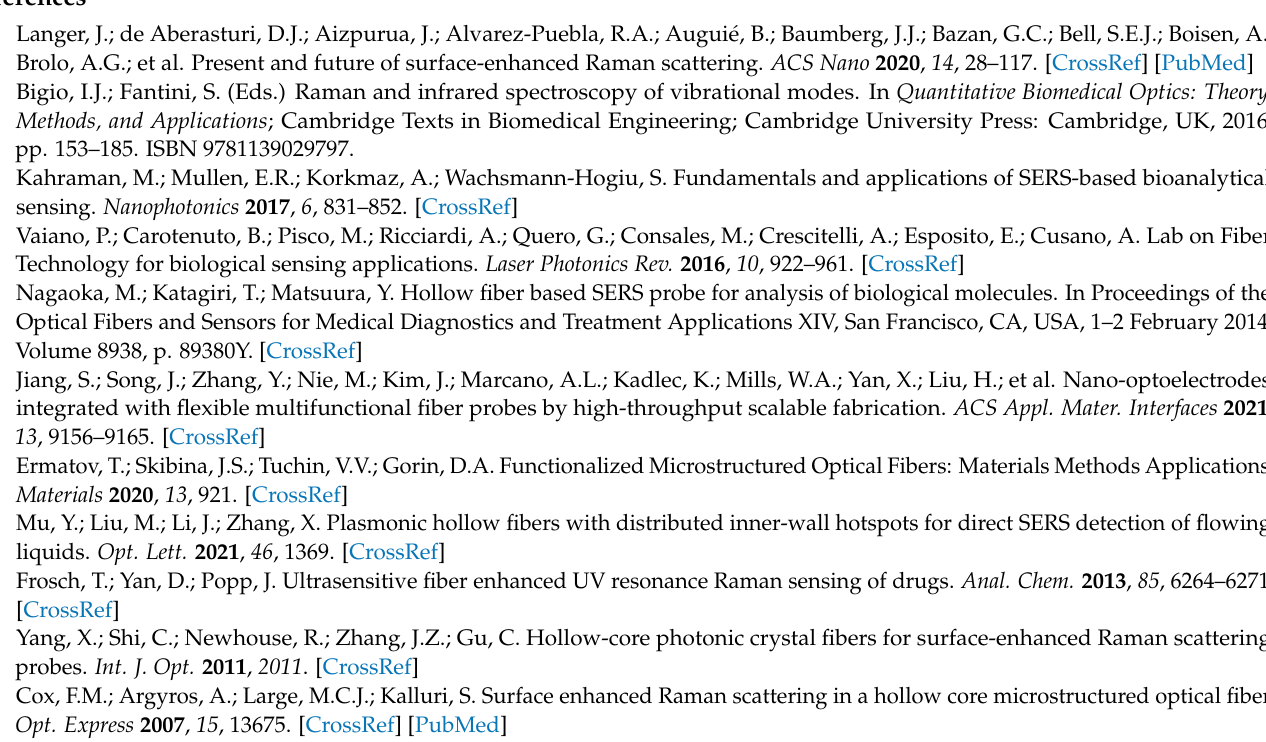
Figure S1. SEM inages of the tip, end and middle sections of the fabricated HC-MOF sensors. Figure S2. Macro photos of HC-MOFs on different stages of SERS substrate fabrication. Figure S3. Shifts in transmission spectra induced by PEi: (a) transmission spectra of the same HC-MOF before and after PEi deposition, with positions of minima selected for analysis labeled as min1 ... min4; (b) shifts in transmission spectra induced by PEi to a set of